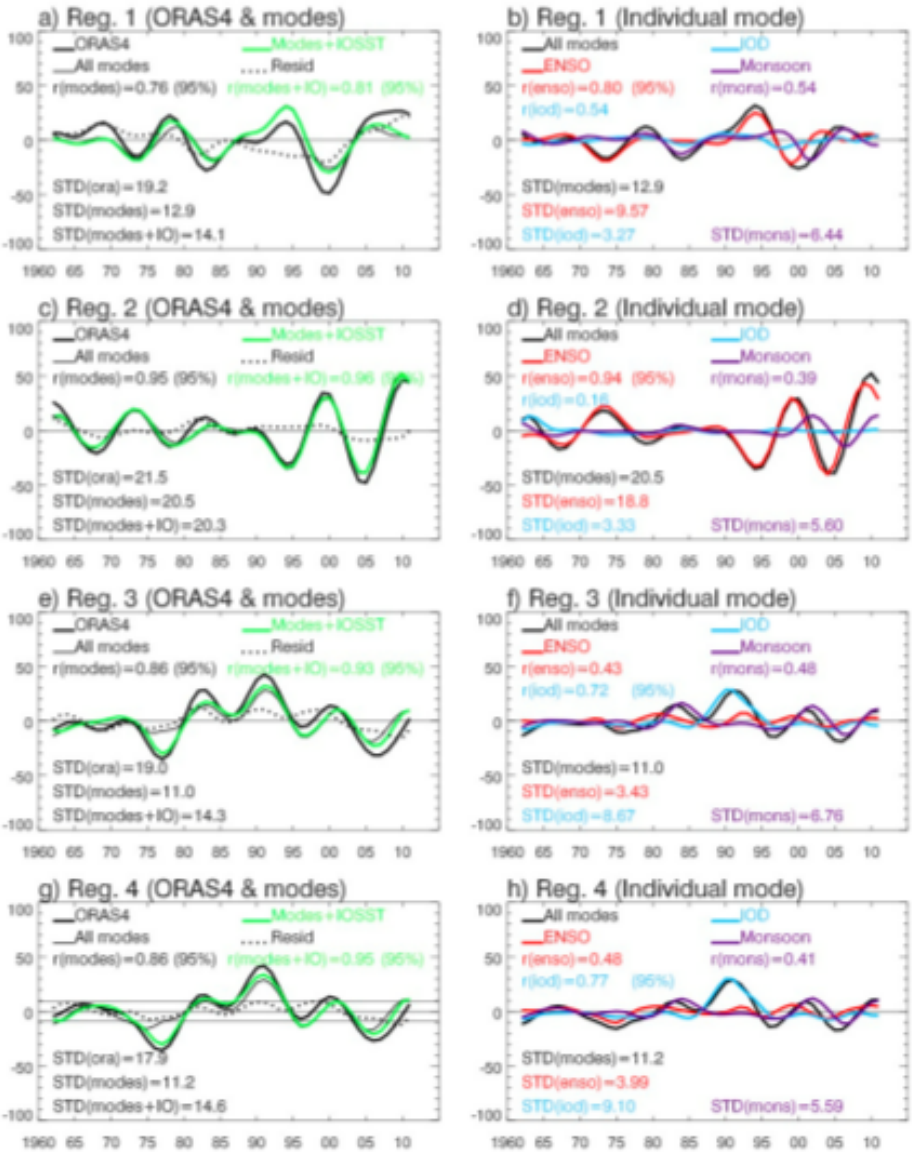
Figure 12. ( a ) The May–October averaged time series of the 8 year low-passed SLA averaged in Reg. 1 of Figures 6–10 from 1962–2011 from ORAS4 (thick solid black), the sum of climate modes’ effects (ENSO + IOD + monsoon; thin solid black), all modes plus IOSST (green), and residual (black dotted), which is ( ORAS4 − ( all modes + IOSST )]; the linear trend for 1962–2011 is removed from each curve; ( b ) same as (a) except for the contributions from all modes (black), decadal ENSO (red), decadal IOD (blue), and decadal monsoon (purple); panels ( c – h ) are the same as ( a , b ) except for the ITF area (Reg. 2 of Figures 6–10), eastern equatorial basin (Reg. 3 of Figures 6–10), and Bay of Bengal coasts (Reg. 4 of Figures 6–10), respectively. The correlation coefficients r in each panel of the left column are between the observed and DLM simulated SLA from climate modes (black) and climate modes + IOSST (green), and those in the right column show the r between each climate mode and the sum of all climate modes. The two horizontal lines in ( g ) show the ± 0.5 STD of ORAS4 observed SLA, which serve as a reference for the composites of Section 3.3. The figure is the same as Figure 11 except for the northern